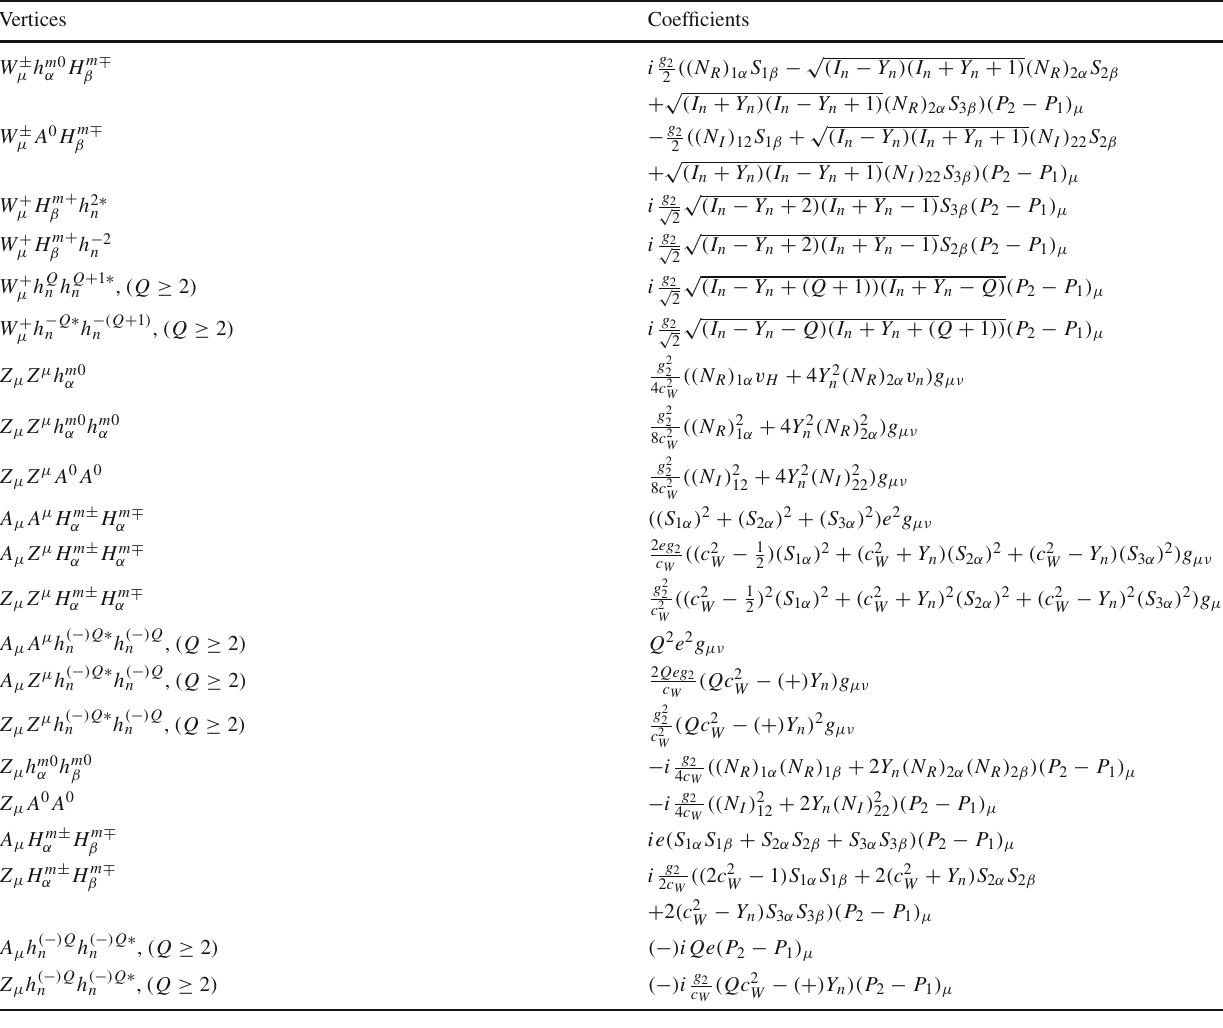
Table 3 Feynman Rules. All momenta flow into the vertex